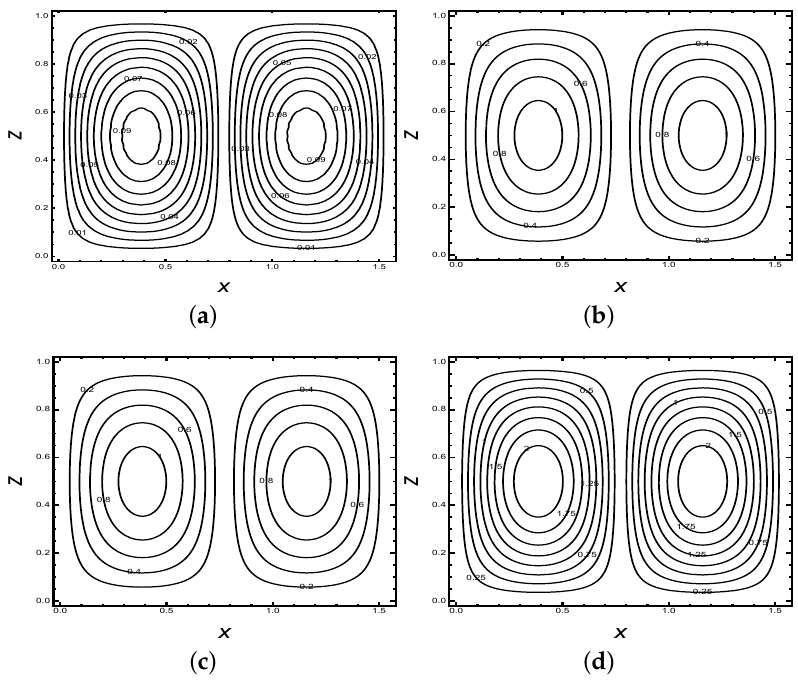
Figure 3. Streamlines for the fixed values of parameters at different scaled time ( a ) τ = 0.1, ( b ) τ = 1.0, ( c ) τ = 2.0, ( d ) τ = 2.5 for the fixed values of Pr = 25, Da = 0.3, ω = 2, δ 1 = 0.05, Γ p = 0.5 and Ta = 20.